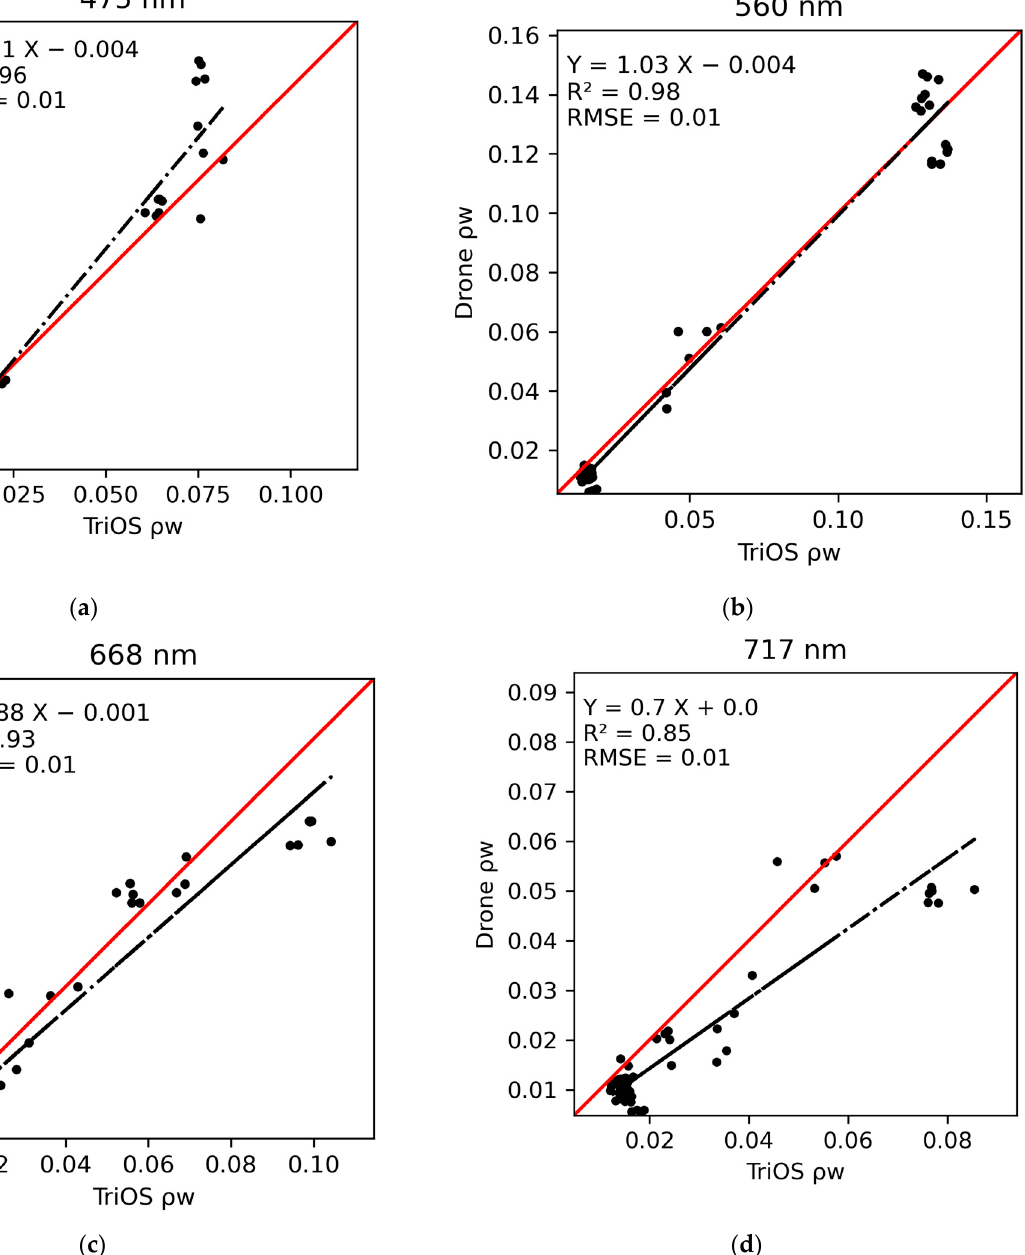
Figure 4. Scatterplots of MS-REM versus in situ (TriOS) measured water-leaving reflectance in Lake Balaton. ( a ) Blue band (475 nm); ( b ) Green band (560 nm); ( c ) Red band (668 nm); and ( d ) Red Edge band (717 nm). Red line = 1:1 line, black line = regression line.